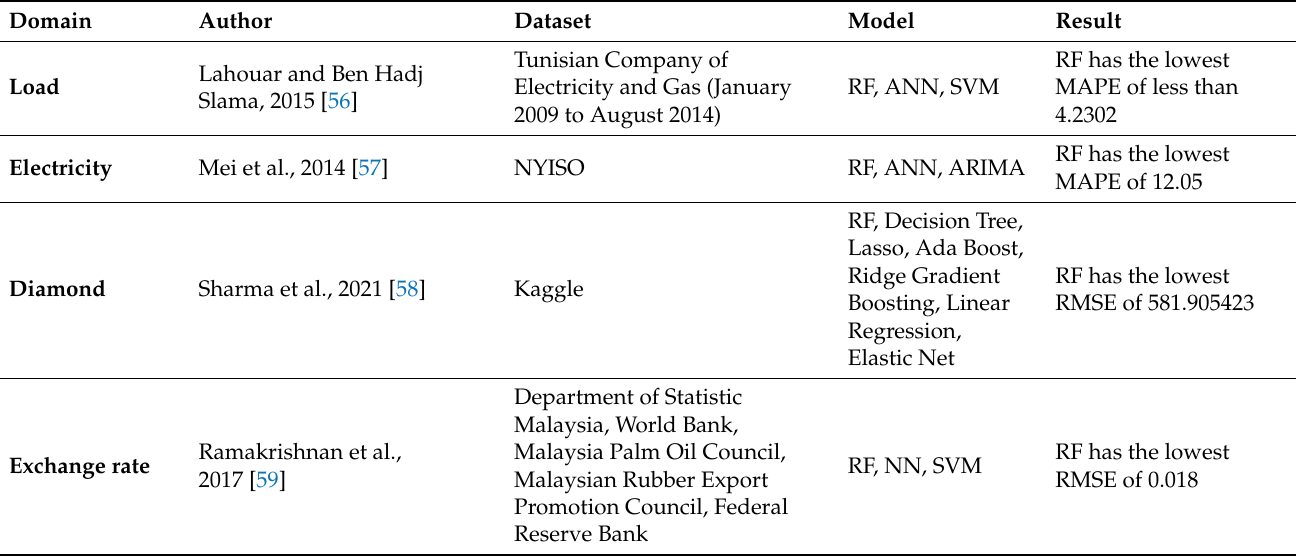
Table 6. RF time-series forecasting from 2006 to